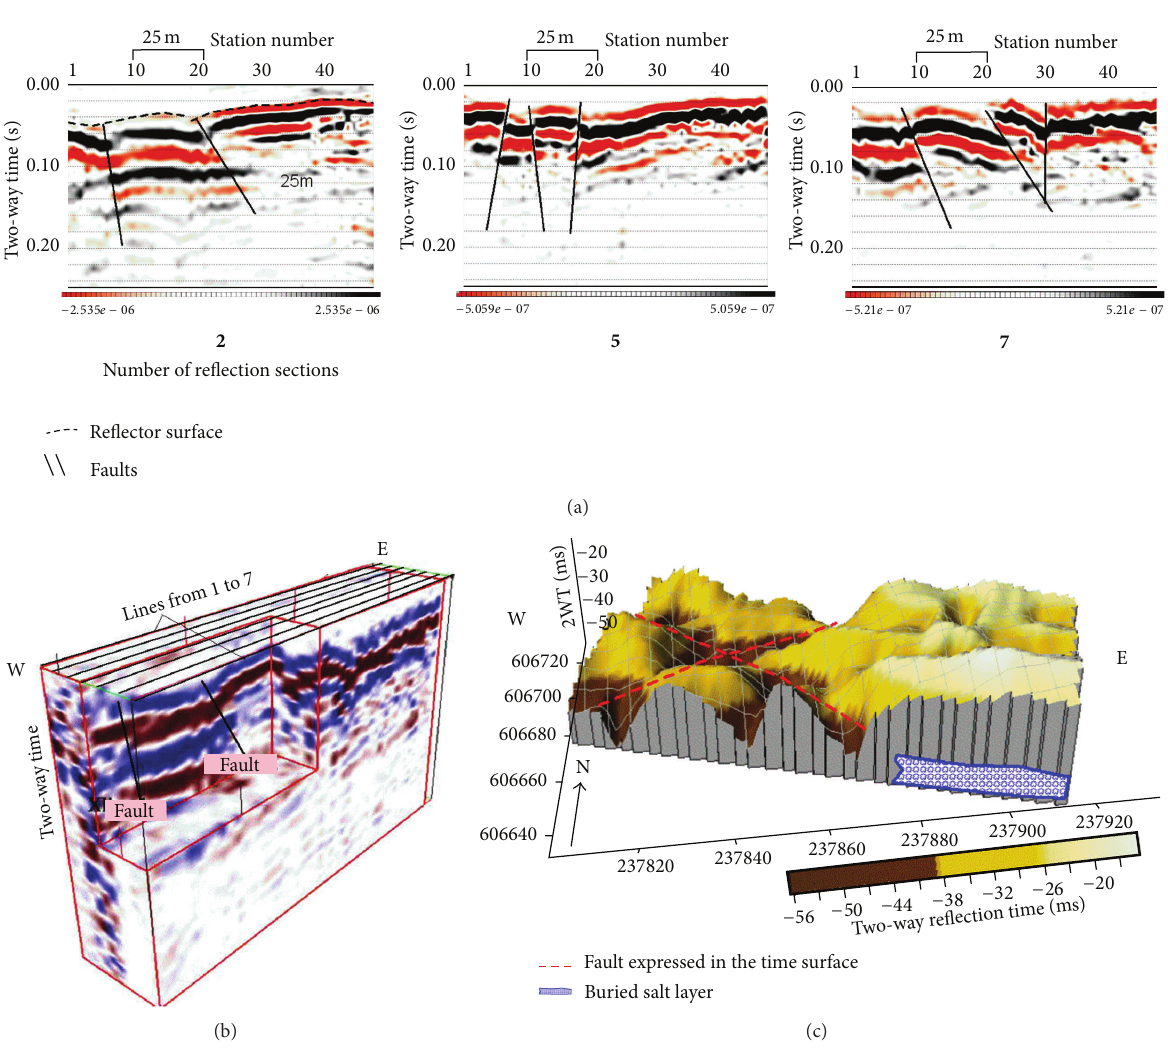
Figure 8: Typical two-way time sections (a) constructed from 3D time cube obtained using 3D imaging approach (b); two-way time map of reflector in the 3D presentation